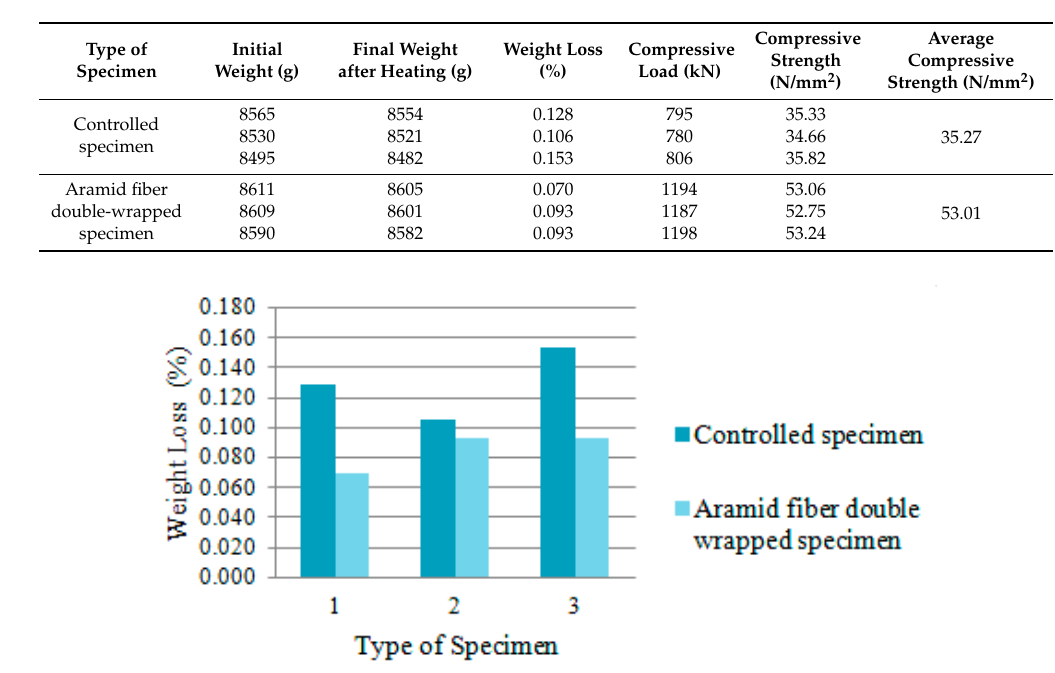
Figure 6. Weight loss at 200 °C—1 h. Table 9. Fire resistance test at 200 ◦ C—2